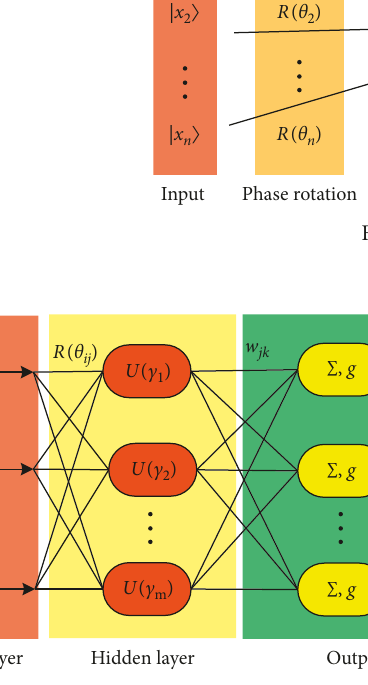
Figure 3: The quantum neuron networks